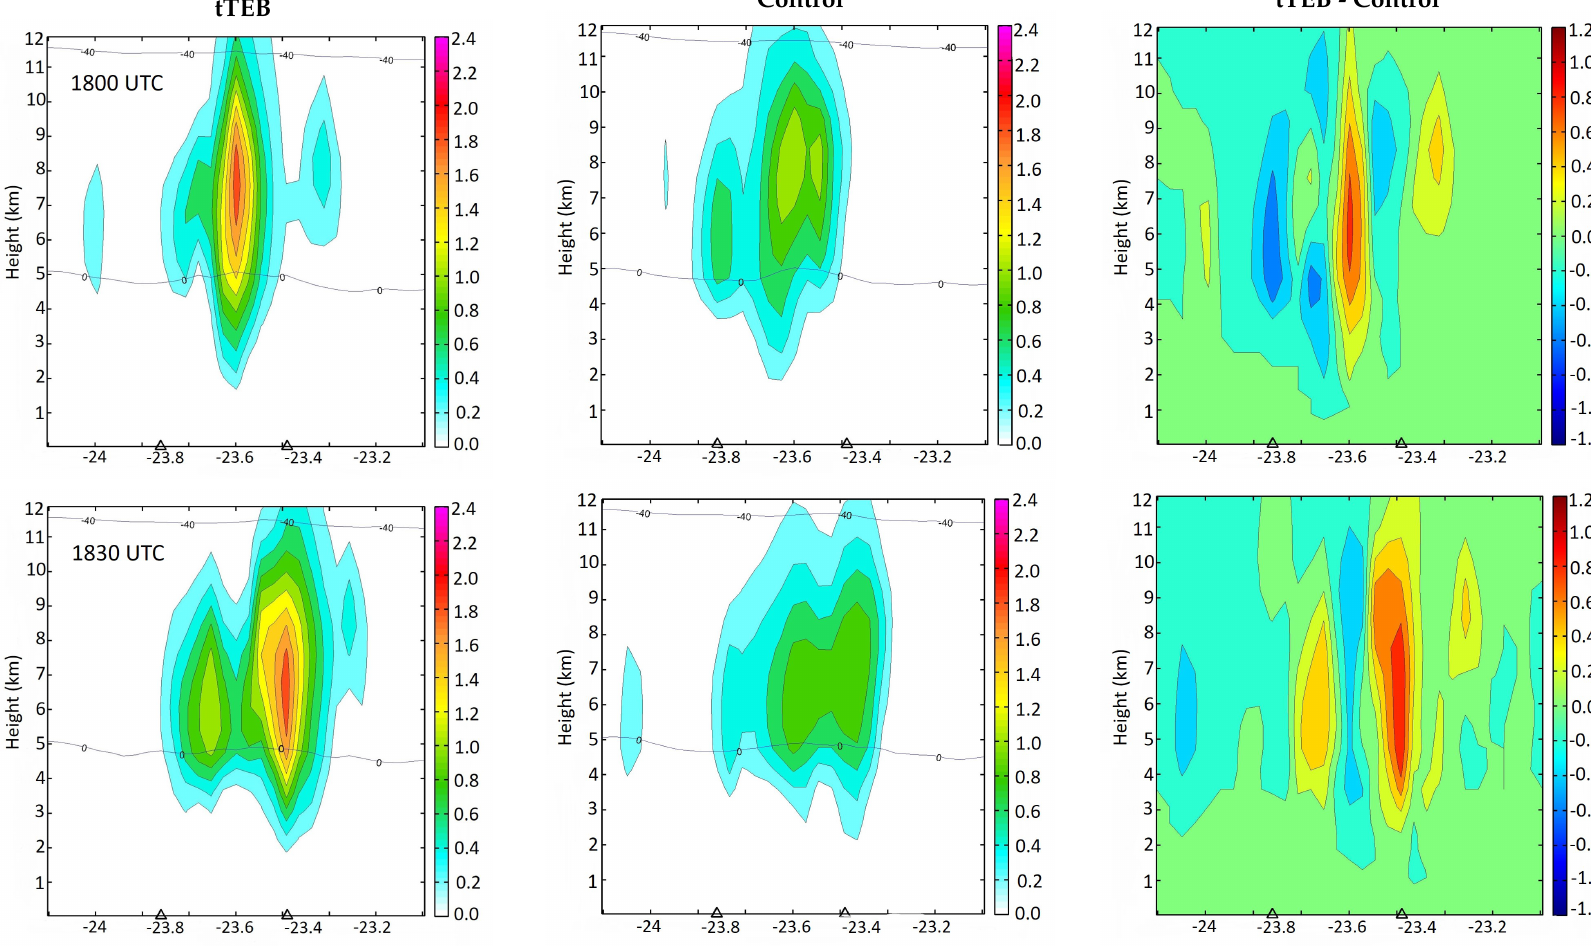
Figure 18. Vertical cross section of mean hail mixing ratio (g kg − 1 ) between 46.9 ◦ W and 46.42 ◦ W at 18 UTC (15 LT) (first row) and 1830 UTC (1530 LT) (second row) along the latitude. The first column shows results of the tTEB experiment, the second column shows results of the control experiment and the third column shows the difference between both experiments. Contours of 0 ◦ C and − 40 ◦ C of air temperature are indicated. Triangles indicate the extension of the urban canopy of the